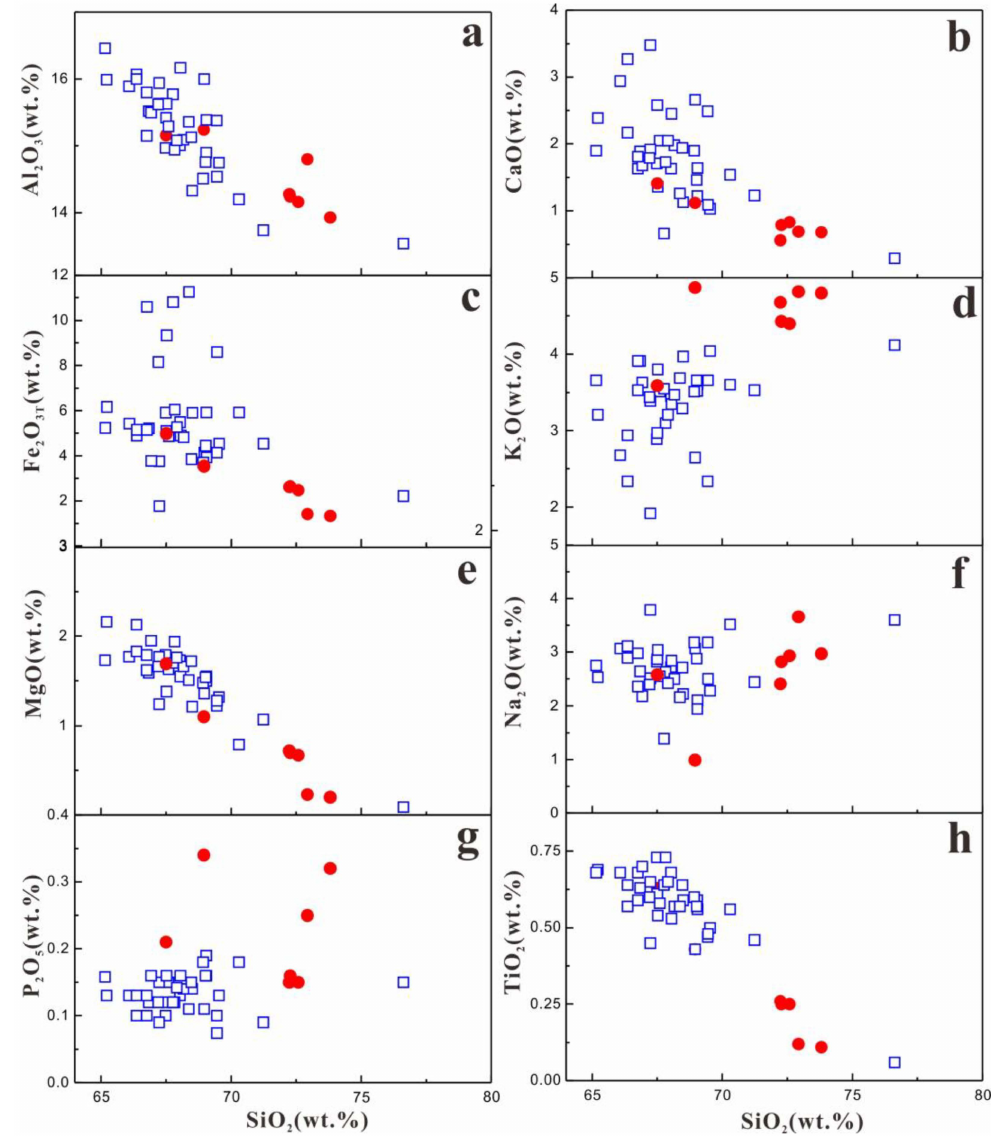
Figure 5. Major element Harker diagrams for Jiningian granodiorite in Dahutang deposit. ( a ) Al 2 O 3 vs. SiO 2 ; ( b ) CaO vs. SiO 2 ; ( c ) Fe 2 O 3 T vs. SiO 2 ; ( d ) K 2 O vs. SiO 2 ; ( e ) MgO vs. SiO 2 ; ( f ) NaO 2 vs. SiO 2 ; ( g ) P 2 O 5 vs. SiO 2 ; ( h ) TiO 2 vs. SiO 2 . Previous data from [20,21,38,39], as shown in Table